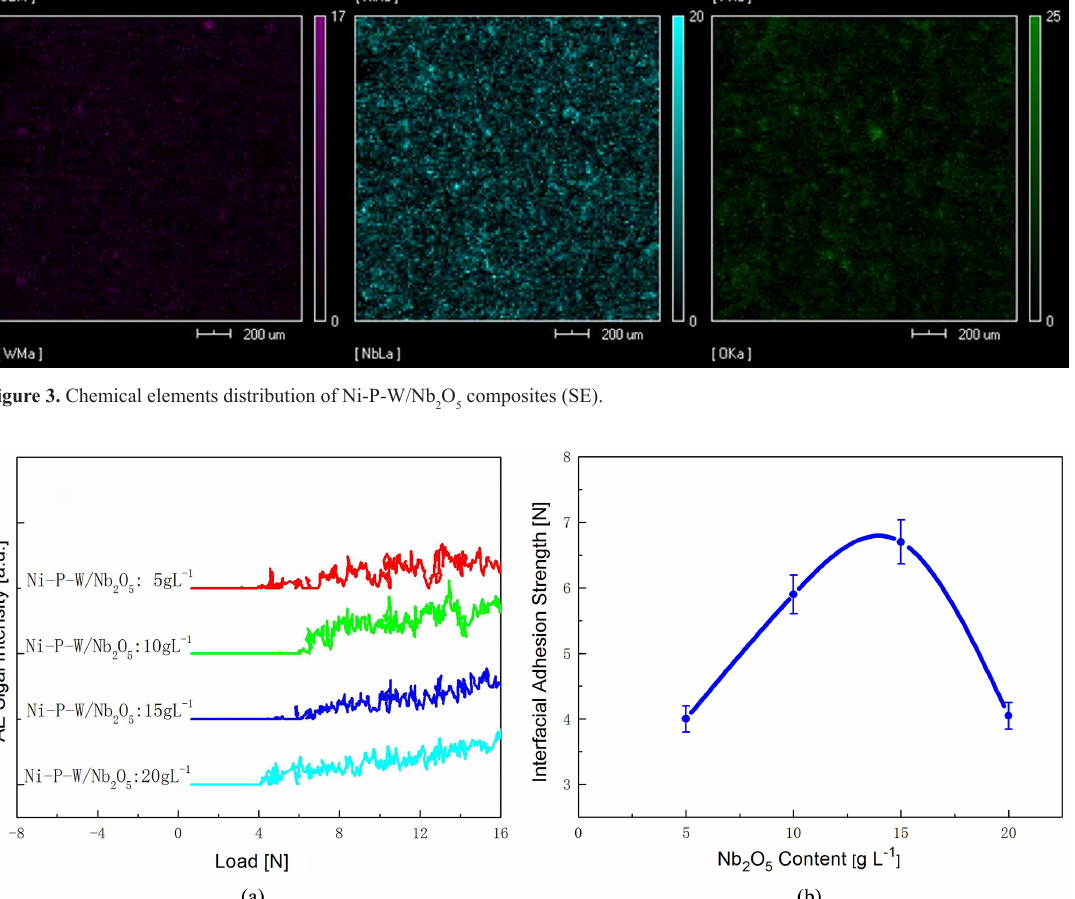
O concentration 2 5